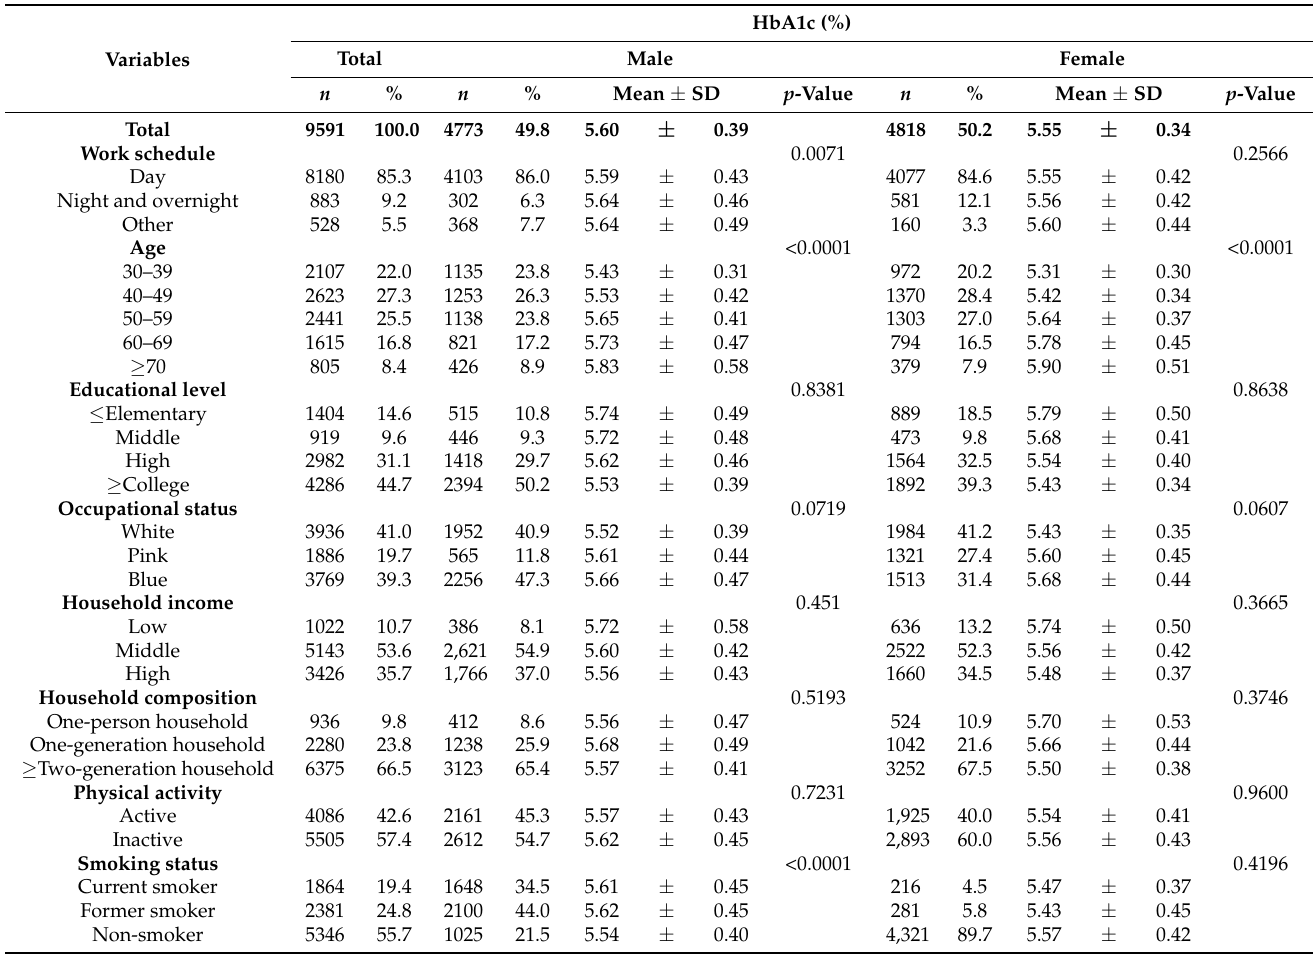
Table 1. General characteristics of the study subjects and analysis of variance for the HbA1c